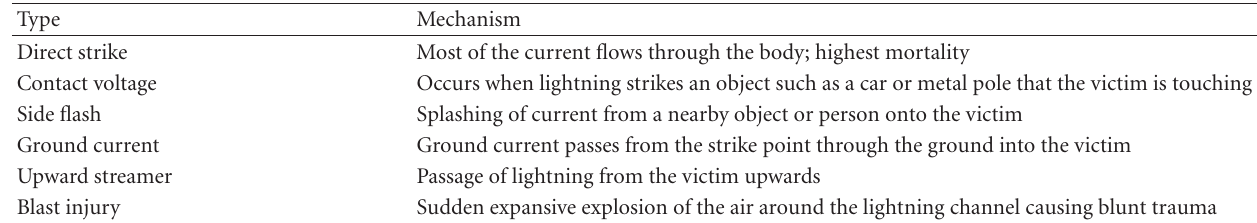
Table 1: Types of lightning strike and ways they a ff ect the human